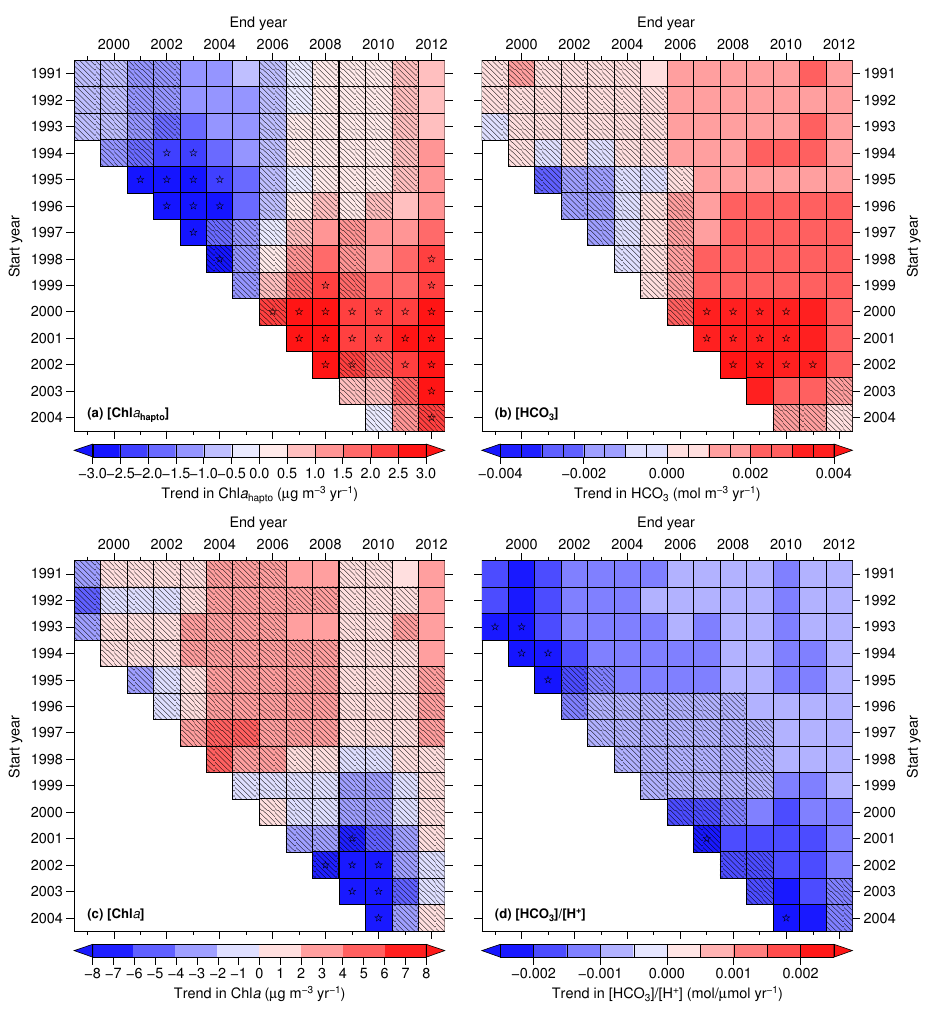
Figure 7. Linear trends for a range of start and end years in (a) Chl a hapto , (b) HCO − based on mean concentrations measured at BATS in the upper 30m of the water column. Boxes with hatch lines demarcate nonsignificant trends. Stars indicate absolute values of trends are greater than 0.2µgm − 3 yr − 1 for Chl a hapto , 0.003molm − 3 yr − 1 for HCO − for Chl a , and 0.002molµmol − 1 yr − 1 for [ HCO −